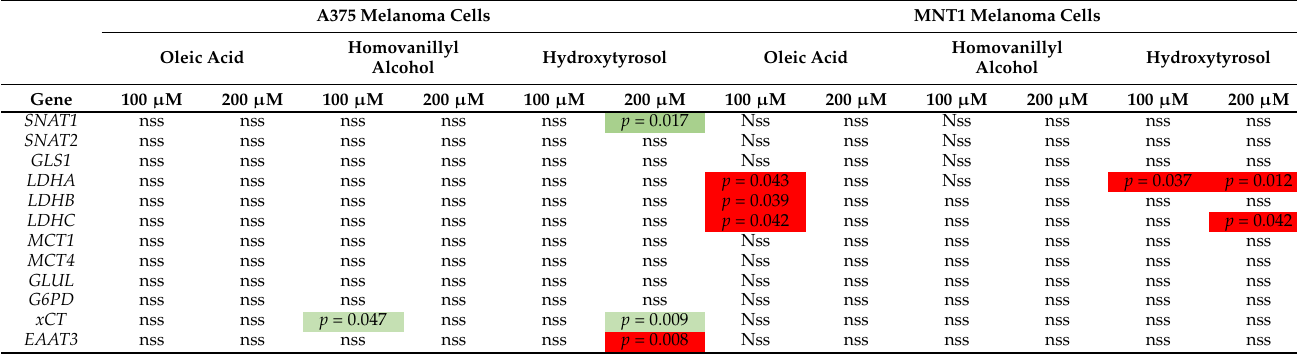
Table 1. Effects of oleic acid, homovanillyl alcohol, and hydroxytyrosol treatment on metabolic gene expression in A375 and MNT1 cells after 48 h of exposure by RT-qPCR